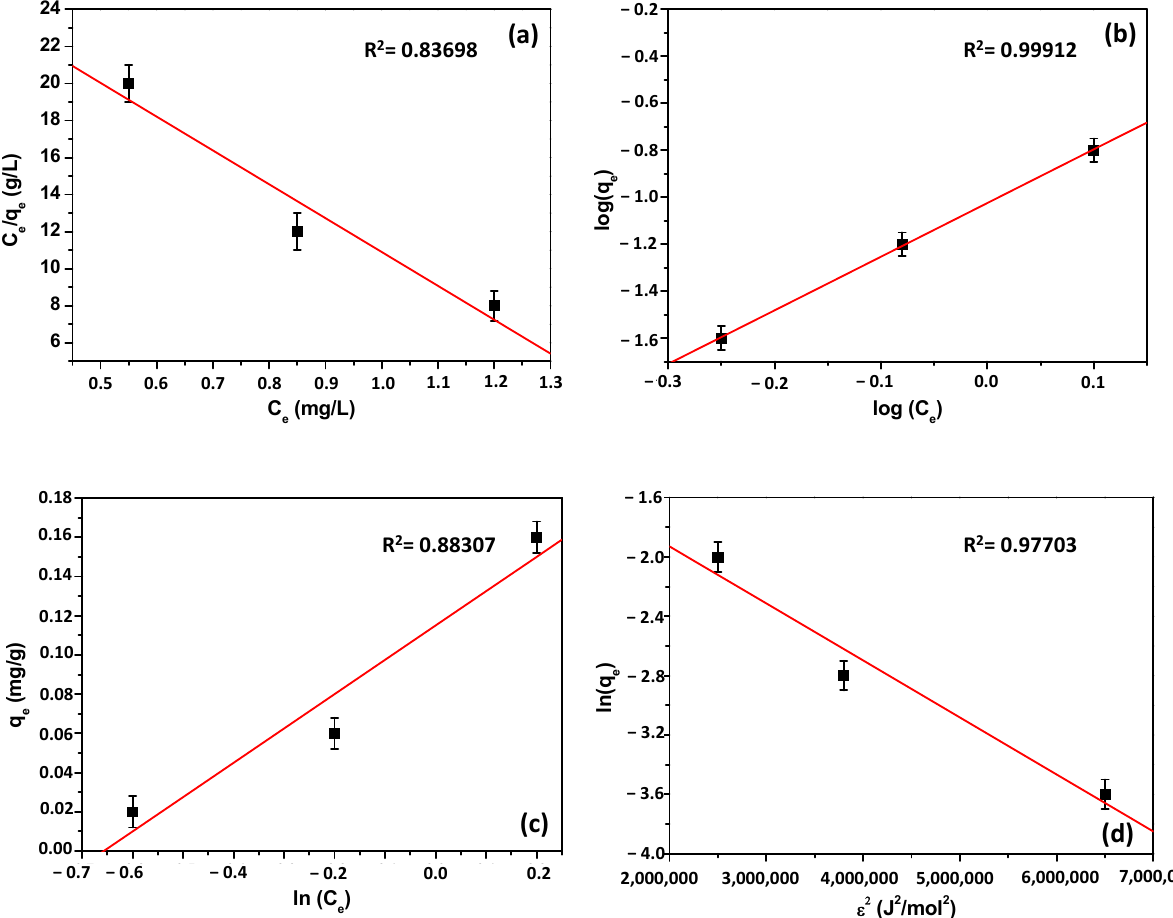
Figure 6. Adsorption isotherms at 298 K: ( a ) Langmuir, ( b ) Freundlich, ( c ) Temkin, and ( d ) Dubinin– Radushkevich models.